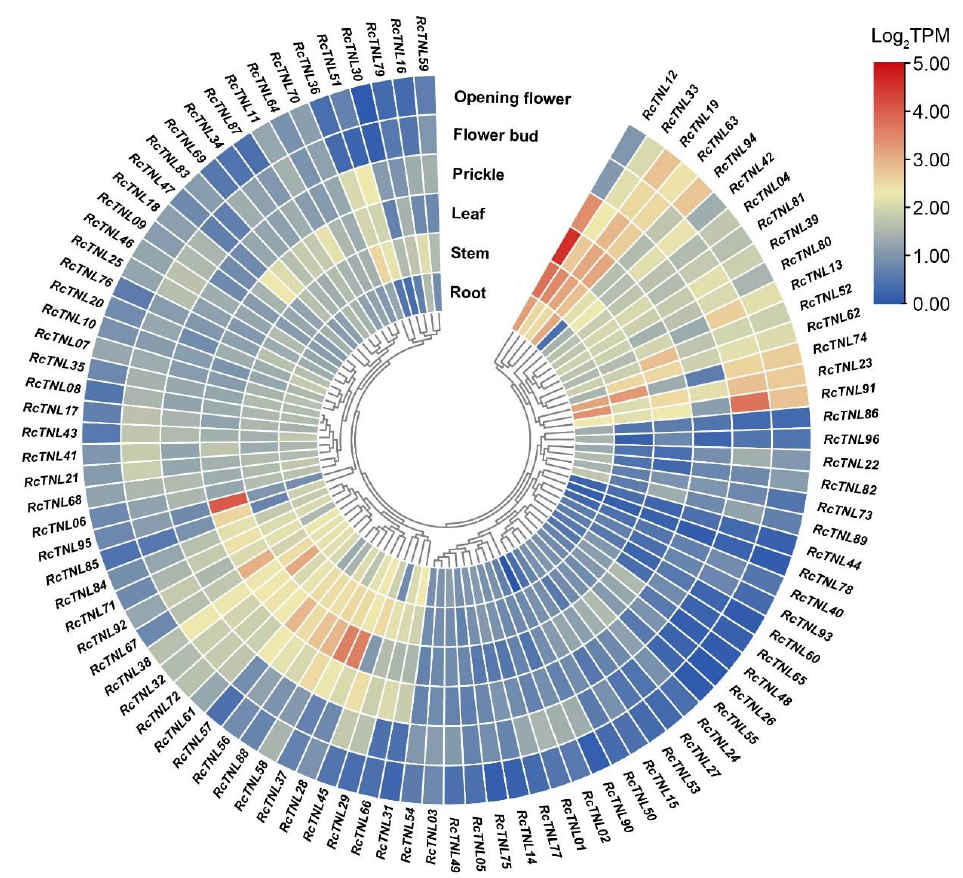
Figure 7. Expression patterns of RcTNL genes in various R. chinensis tissues. The expression of RcTNL genes in the various tissues is represented on a heatmap using log 2 TPM (transcripts per million) values. The innermost circle shows clustering by gene expression patterns. The blocks change from blue to red, indicating a change in the log 2 TPM values from low to high.